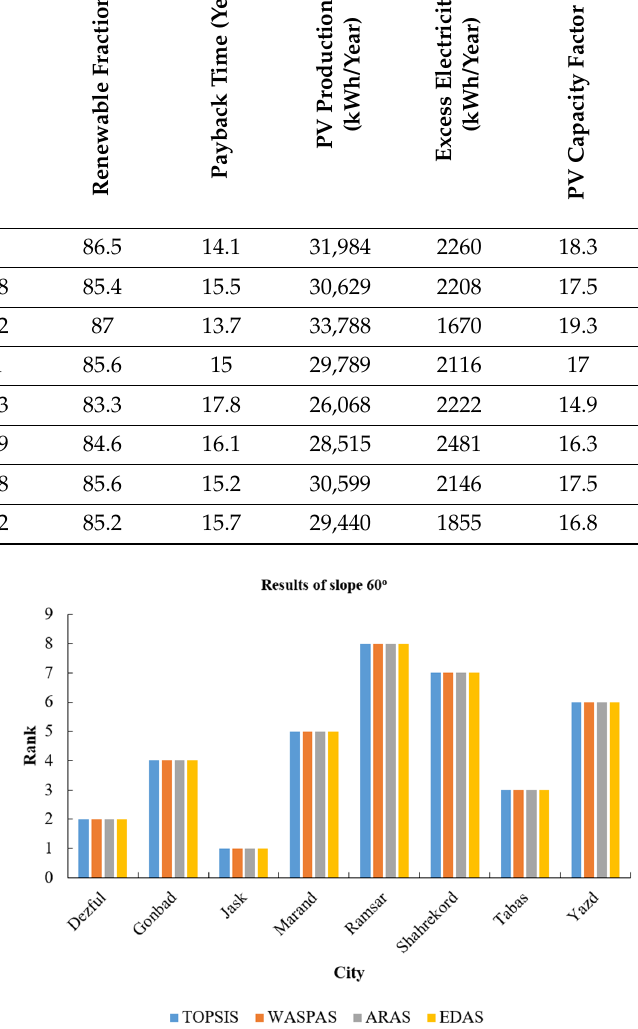
Figure 12. Comparing the ranking of cities on a 30° slope. The decision-making matrix was created to rank the cities on a 60° slope. The results are provided in Table 13. Table 13. The 60° slope decision-making matrix.